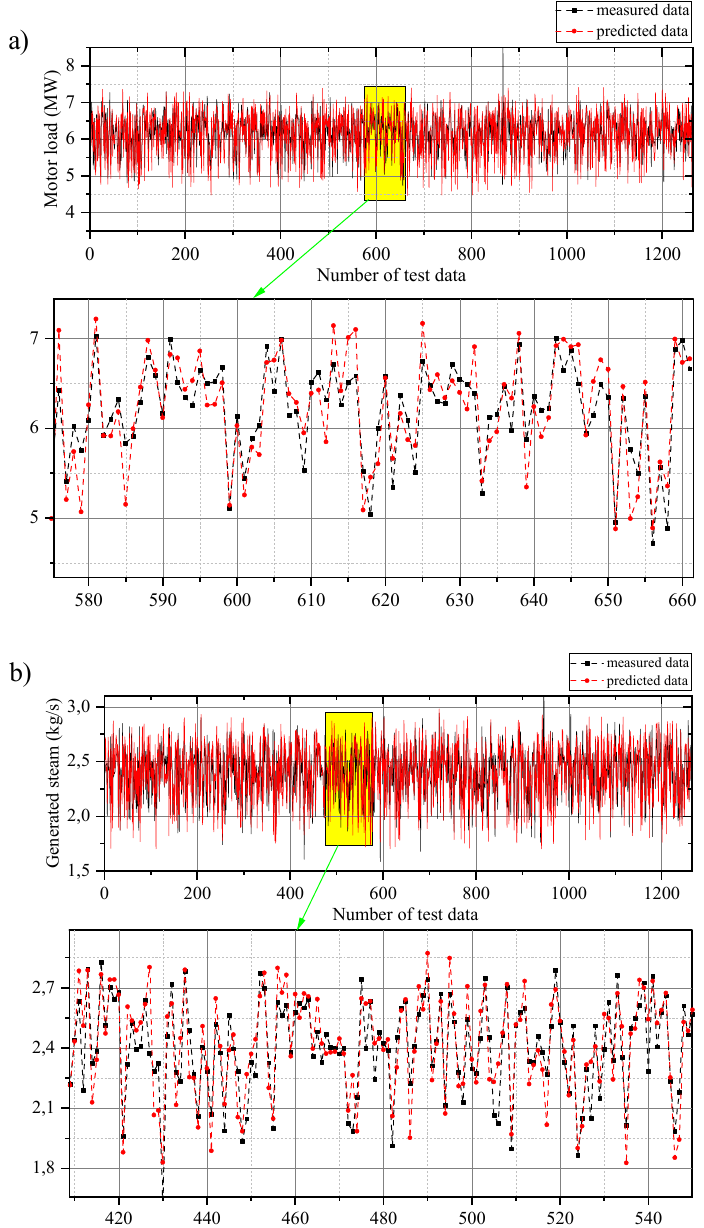
Figure 17. Test samples of ACO to estimate refining motor load ( a ), and refining steam generation ( b ).